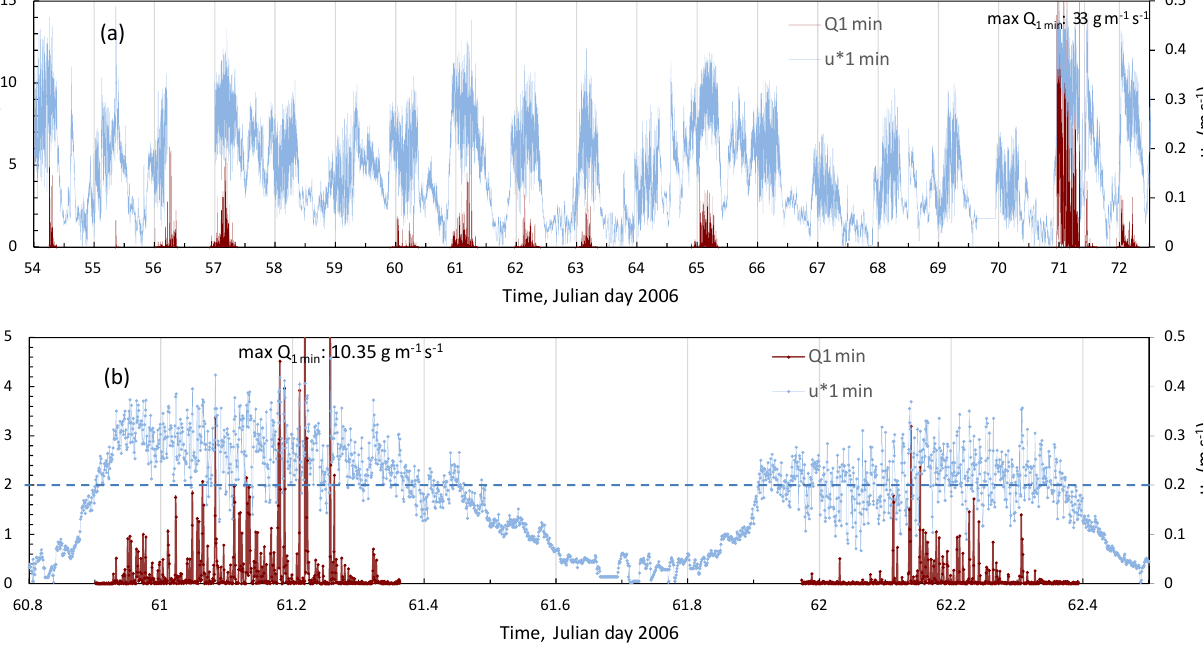
Figure 1. (a) Observed time series of 1min averaged saltation flux, Q 1min (gm − 1 s − 1 ) , and friction velocity, u ∗ 1min (ms − 1 ) , for the JADE study period; (b) an enlarged plot of (a) for the erosion events on days 61 and 62. Note that the axes in (b) have different scales than in (a)